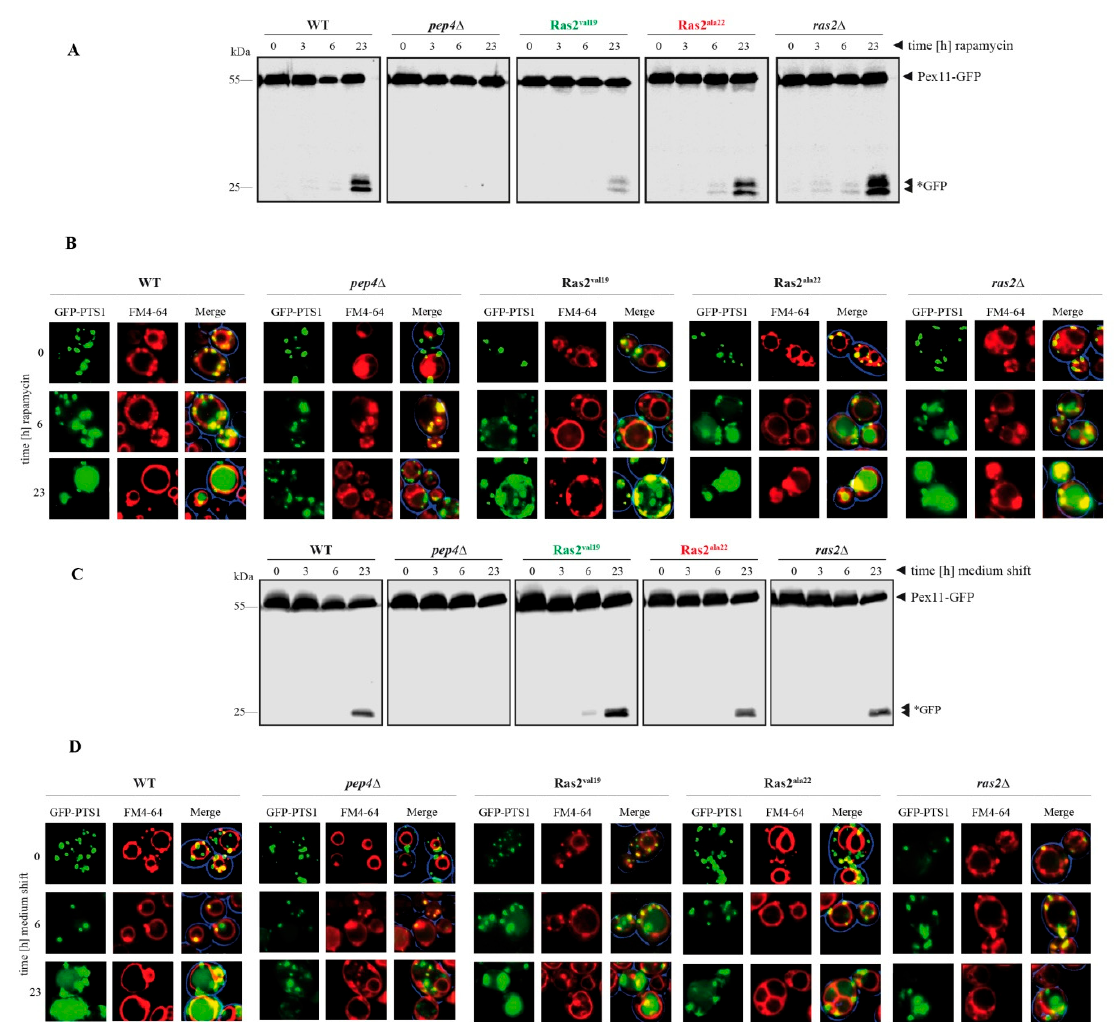
Figure 3. Time-dependent degradation of peroxisomes: rapamycin-triggered peroxisome breakdown occurs fast in Ras2 OFF cells, while pexophagy occurs fast in Ras2 ON cells. ( A ) The impact of the Ras2 mutants on rapamycin-induced bulk autophagy-related peroxisome degradation was monitored in a time-dependent manner. Compared to WT cells, the Ras2 ON (Ras2 va119 ) cells exhibited a reduced amount of free *GFP after 23 h. In contrast, Ras2 OFF (Ras2 ala22 ) showed an elevated level of *GFP, which is already visible after 6 h. ( B ) Peroxisome degradation was monitored via the fluorescence microscope in glucose-grown cells after rapamycin-treatment. In WT, the peroxisomes were detectable as green dots (GFP-PTS1) and the lumen of the FM4-64-stained vacuole showed no signals at t = 0 h. At the end of the rapamycin assay (t = 23 h), the lumen was filled with a diffuse green signal, indicating the breakdown of peroxisomes and the release of free *GFP. This signal was weaker in the vacuoles of Ras2 ON cells after 23 h, while it was already visible after 6 h in Ras2 OFF cells. ( C ) The influence of the Ras2 mutants on pexophagy was monitored in a time-dependent manner. The cells were grown on oleate medium and then shifted to glucose-containing pexophagy medium. Compared to WT, the Ras2 OFF cells exhibited reduced amount of free *GFP after 23 h. In contrast, Ras2 ON showed an elevated level of *GFP already after 6 h. ( D ) Pexophagy was monitored via the fluorescence microscope. In WT cells, the peroxisomes were detectable as green puncta (GFP-PTS1) and the lumen of the FM4-64-stained vacuole showed no signals at t = 0 h. At the end of the pexophagy assay (t = 23 h), the lumen was filled with a diffuse green signal, indicating the degradation of peroxisomes and the release of free *GFP. This signal was slightly weaker in the vacuoles of Ras2 OFF cells after 23 h, while it was already partially visible after 6 h in Ras2 ON cells.